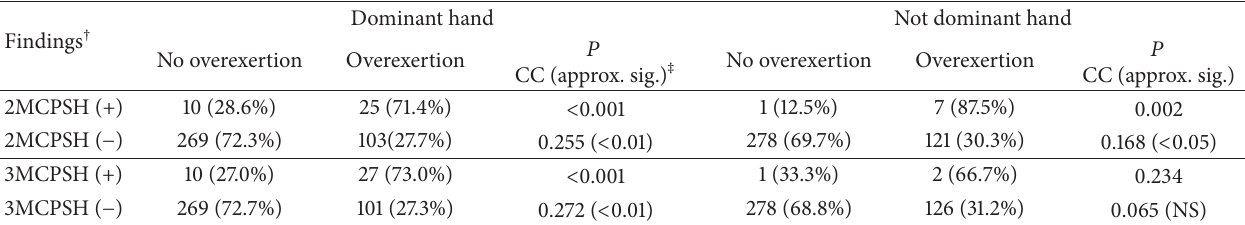
Table 3: Findings in MCP joints grouped according to the hand dominance.